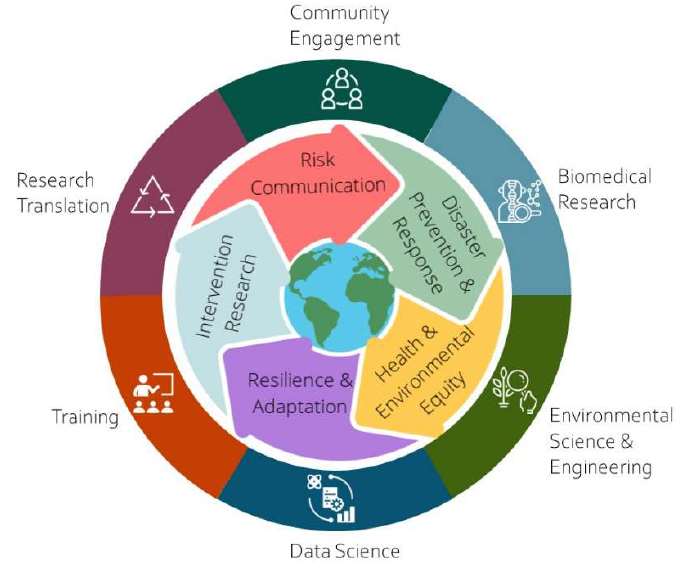
Figure 2. SRP grantees work across multidisciplinary teams to develop advanced sampling tech- niques, use innovative modeling approaches, design sustainable cleanup strategies, and work closely with communities to promote health and resilience in the context of climate change.